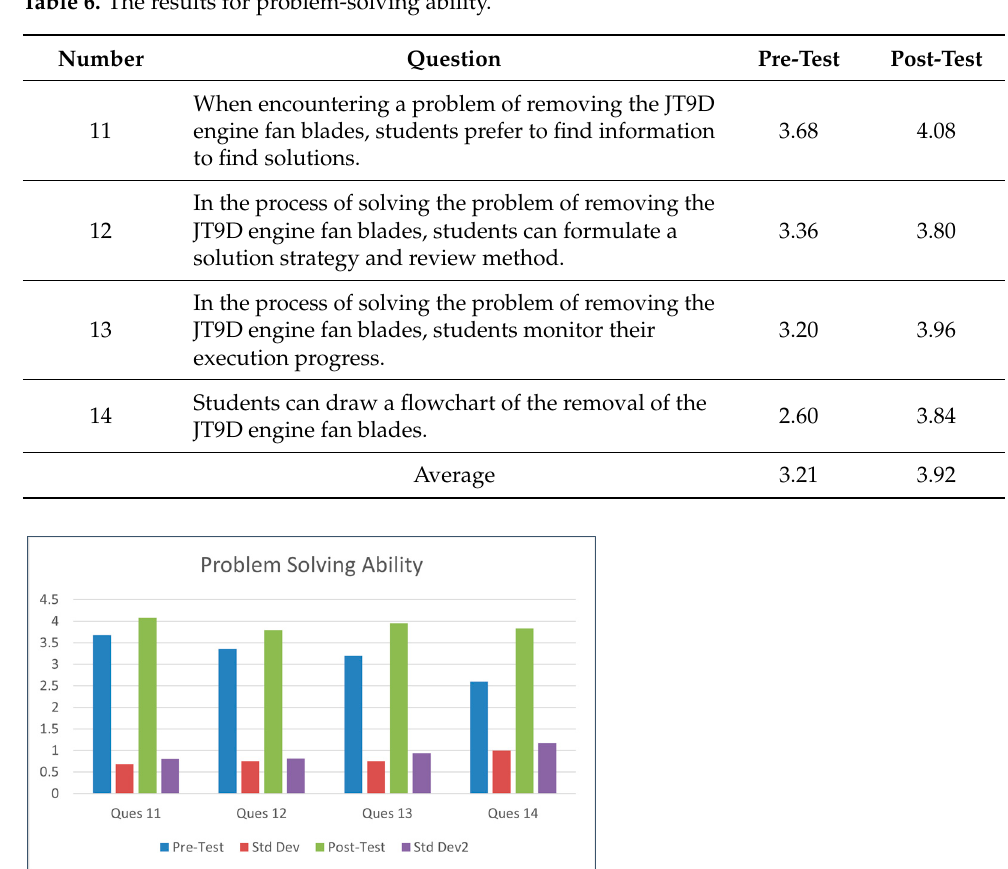
Figure 8. Students’ problem commenting ability in the previous test and the post-test.